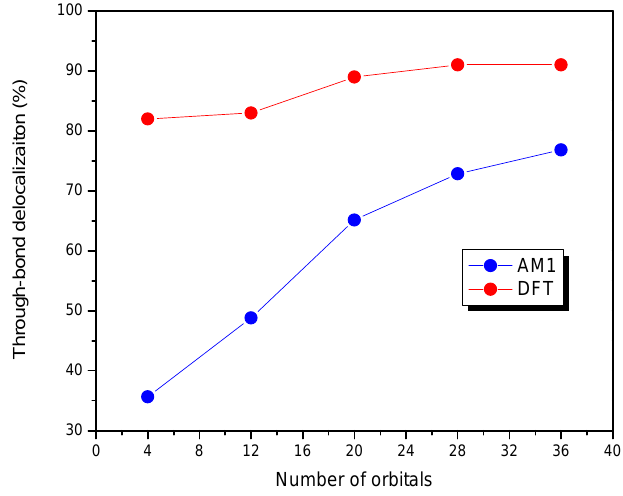
Figure 7. Various truncated CM model for molecule 4 with different optimized geometries for AM1 geometry (blue) and DFT geometry (red) [47]. Reproduced with permission from American Chemical